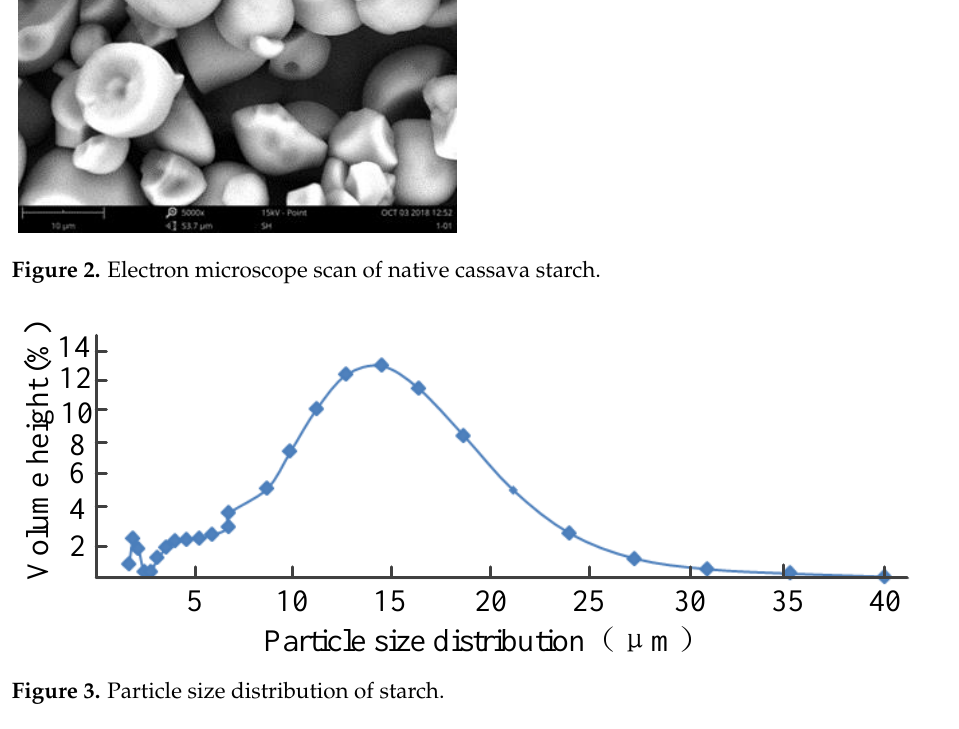
Figure 3. Particle size distribution of starch.